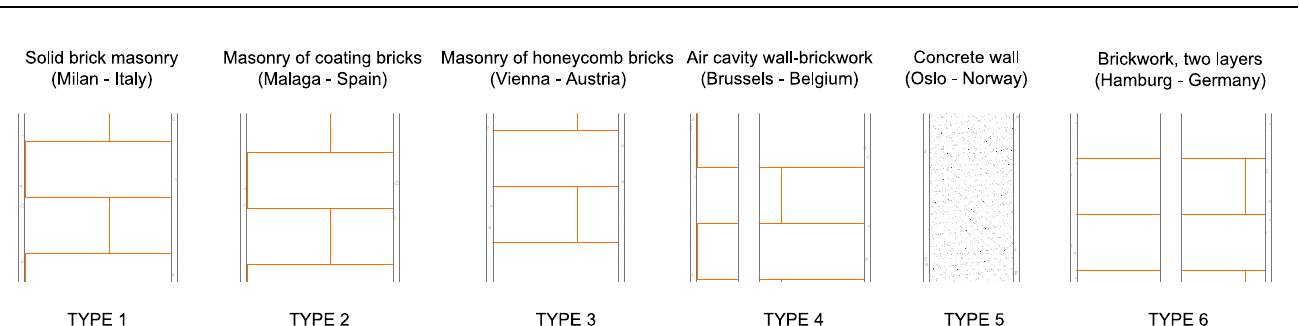
Figure 1. Types of wall stratigraphy determined by TABULA by reference location.